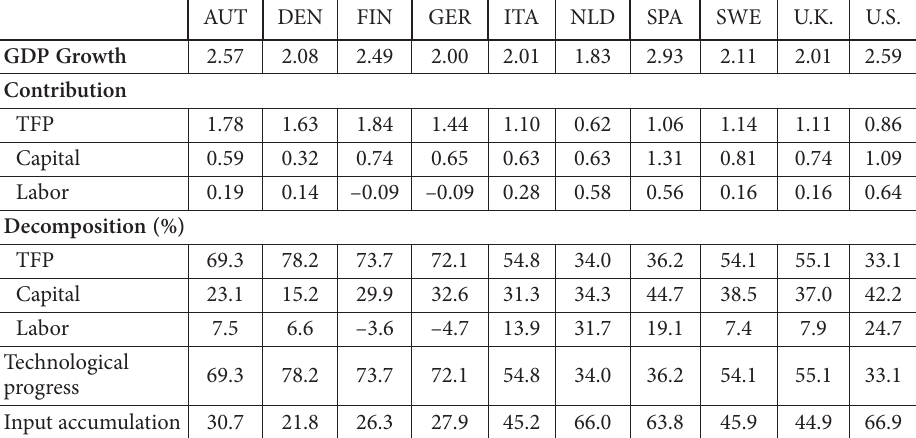
Table 4. Solow’s method. GDP Growth Decomposition,